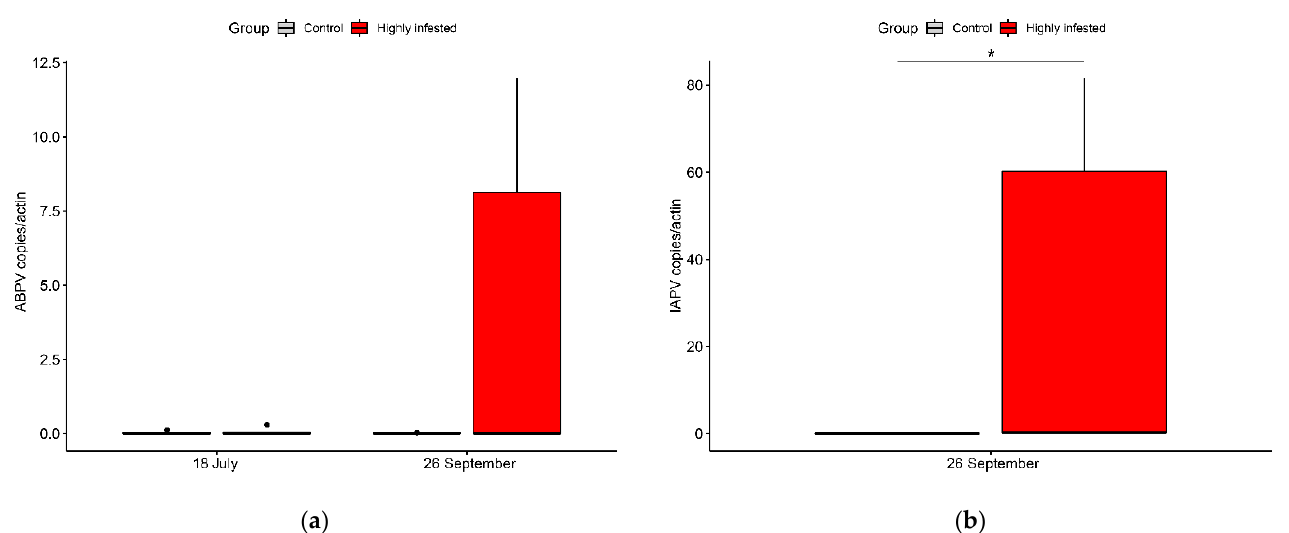
Figure 5. Viral loads in in honeybees of highly infested and control hives over time: ( a ) ABPV loads (copies/actin); ( b ) IAPV loads (copies/actin). Infested hives Nos. 522 and 505 showed a high ratio of viral copies in September for both ABPV and IAPV. A significant difference (*, p < 0.05, t -test) between studied groups was seen for IAPV.